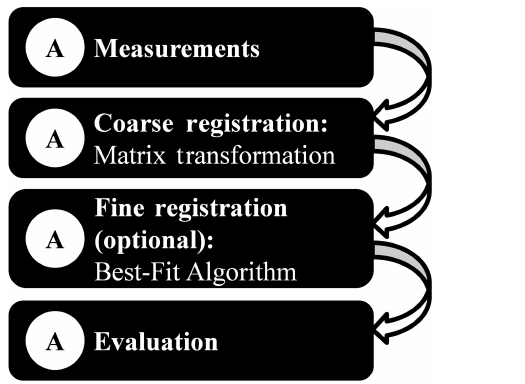
Figure 3. Flat reference artefact for testing the qualification princi- ple.